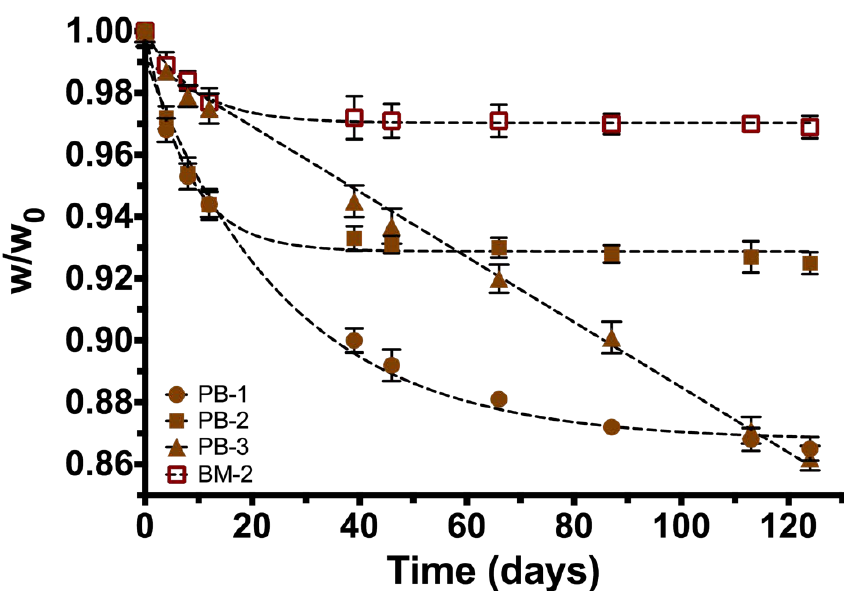
Figure 4. Degradation rates of copolymer formulations during hydrolysis process (days). PB-1, PB-2, PB-3: different copolymer formulations (poly(lactic acid) (PLA)/ poly( ε -caprolactone) (PCL) rates), BM-2—sample (PLA/PCL/ IONPs).